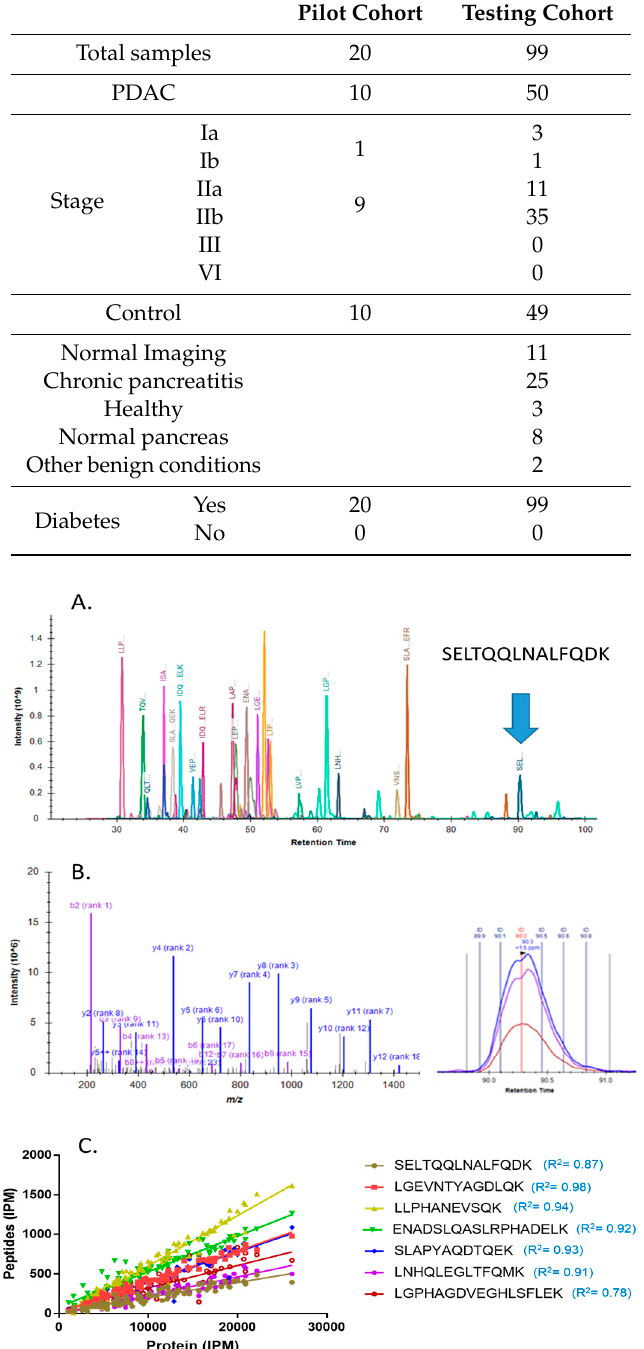
Table 1. Summary of sample sets.